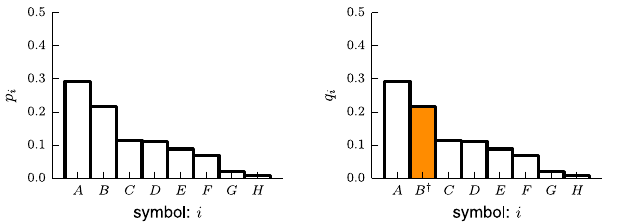
FIG. 2. Illustration of our toy model, where p (left diagram) and q (right diagram) have the same rank-frequency distribution but differ in the probability for individual symbols. In this example, p and q are the same ( p while the symbol i ¼ B in p is replaced by i ¼ B † in q with p FIG. 3. The spectrum